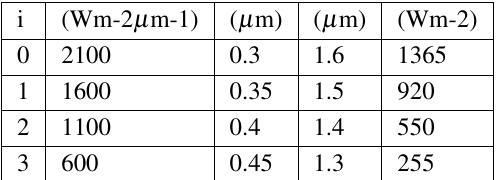
Table 1. The solar intensities, wavelength, and solar constant correspond to different air